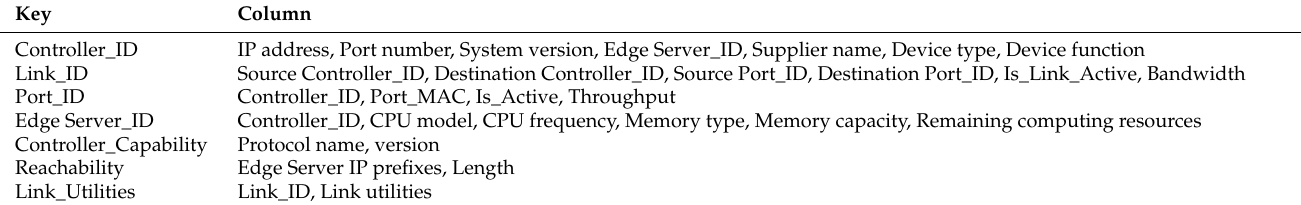
Table 1. Key–value table of global view storage.